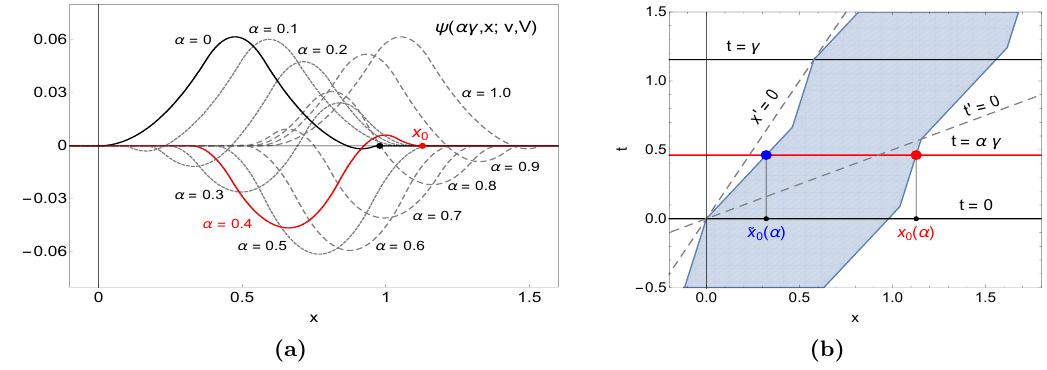
Figure 8 . (a) Oscillon ( (cid:13)(cid:11); x ; v; V ) with V = 0 : 5 and v = 0 : 3 for sevaral values of (cid:11) . (b) A worldsheet of the oscillon and the surface of simultaneity at t = 0 : 4 (cid:13) in the laboratory reference frame.